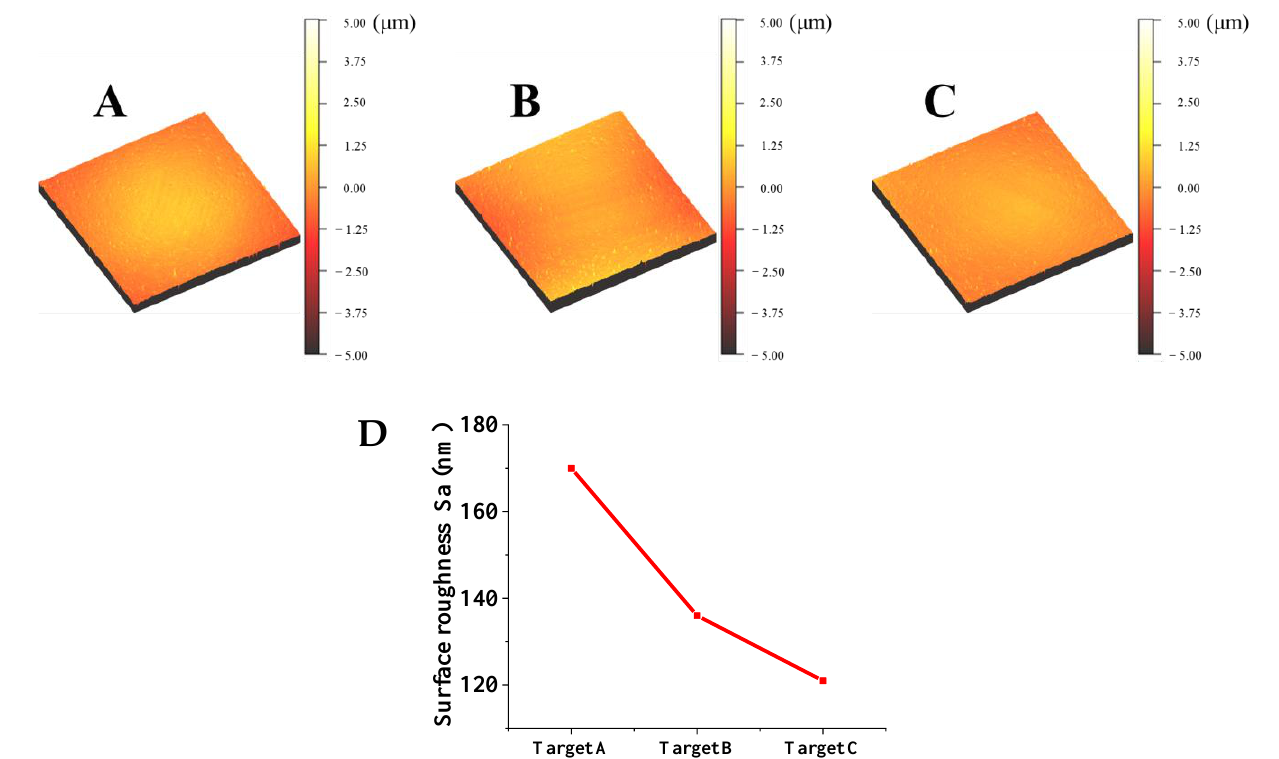
Figure 4. Surface roughness of films prepared from Ti targets with different purities. ( A ) Target A; ( B ) Target B; ( C ) Target C; ( D ) Variation of the surface roughness with different purities of targets.